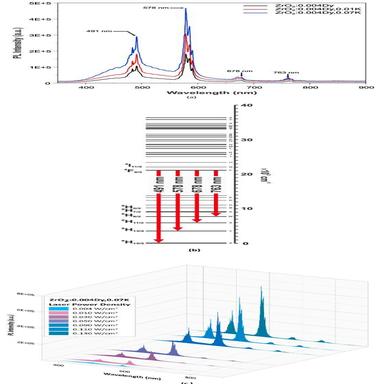
(a) PL spectra of ZrO2:0.004Dy3+ phosphors with K+ doping at various concentration (b) Energy level diagram of Dy3+ ions in the ZrO2 host (c) PL spectra recorded from the sample ZrO2:0.004Dy3+, 0.007K+ at probing powers ranging from 0.004 to 0.130 kW cm− 2 from the lower to the upper curves.